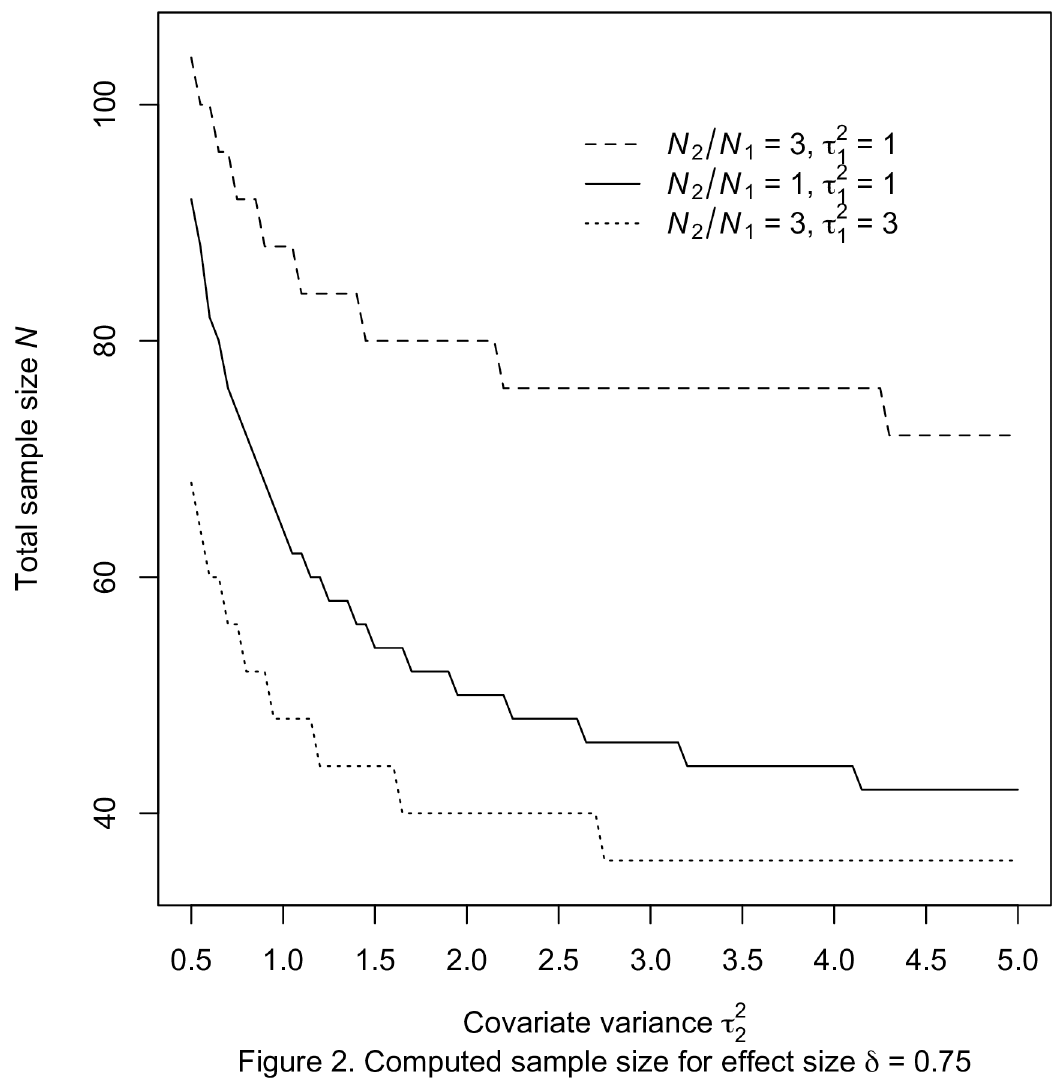
Fig 2. Computed sample size for effect size δ =